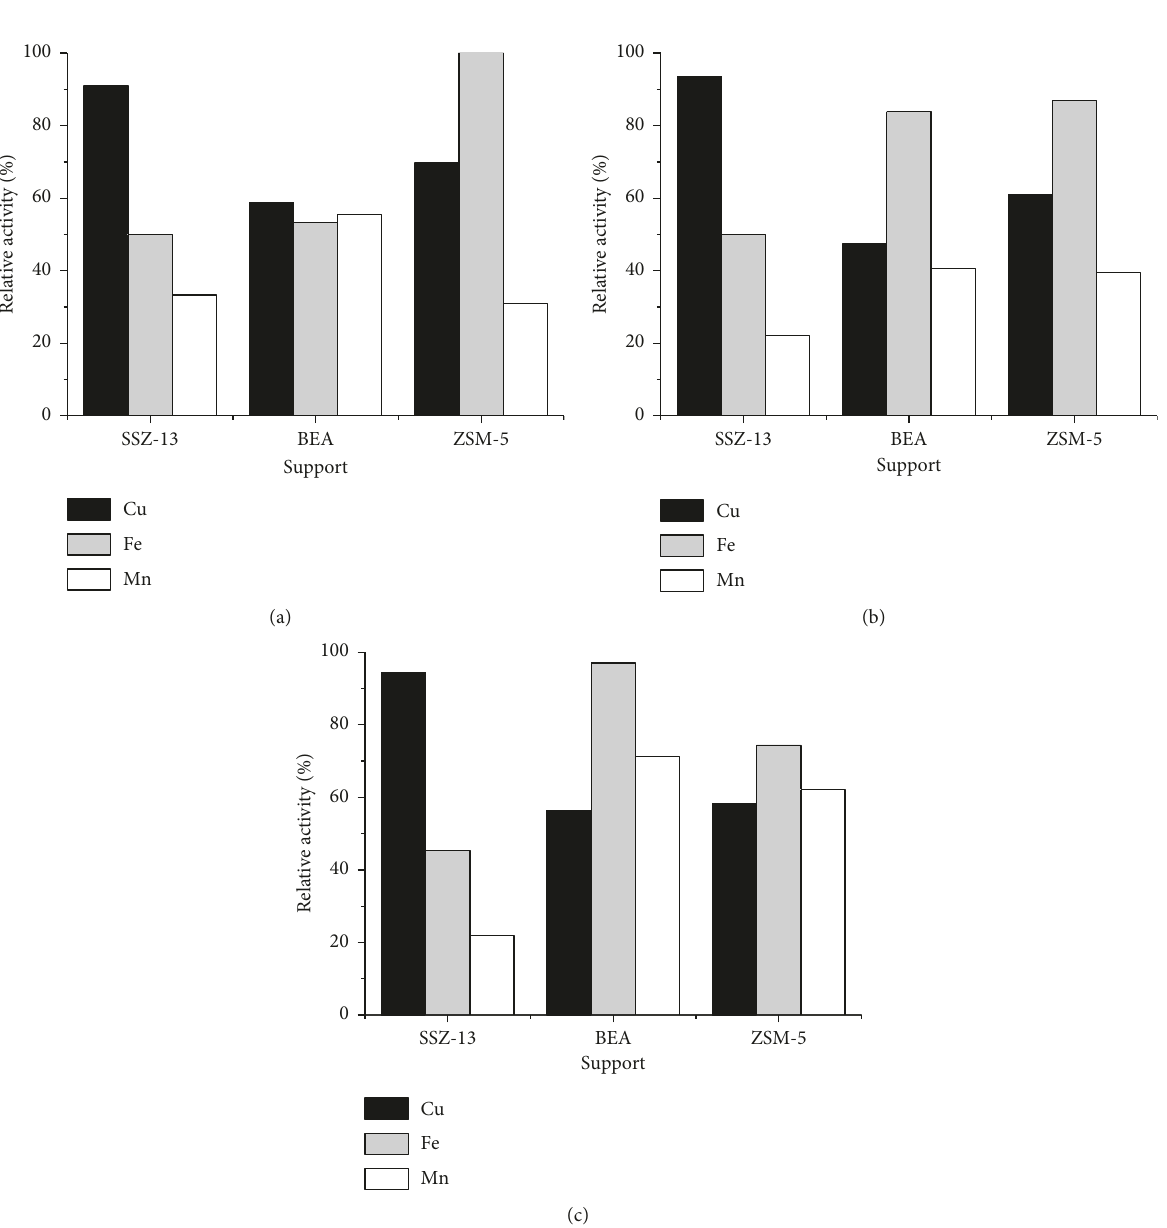
Figure 7: Relative catalytic activity (%) of Cu-zeolite, Fe-zeolite, and Mn-zeolite at (a) 300, (b) 400, and (c) 500 °